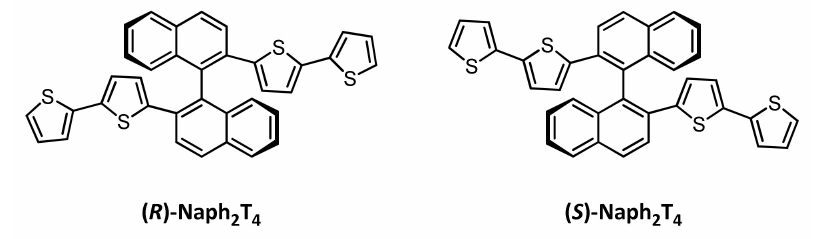
Figure 2. The two antipodes of BT 2 T